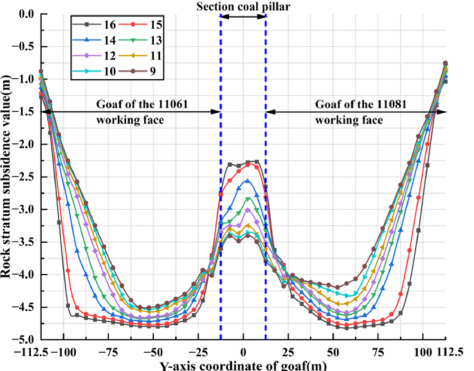
Figure 10. Subsidence values of overlying strata in the dip model of the